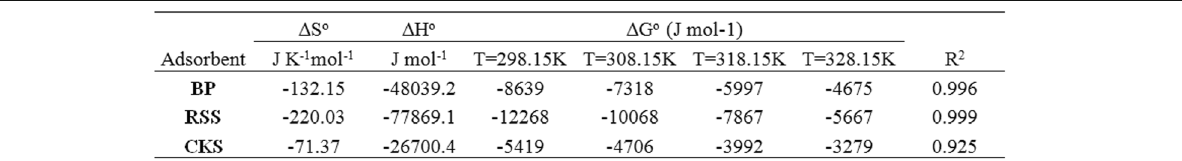
Table 3 Thermodynamic